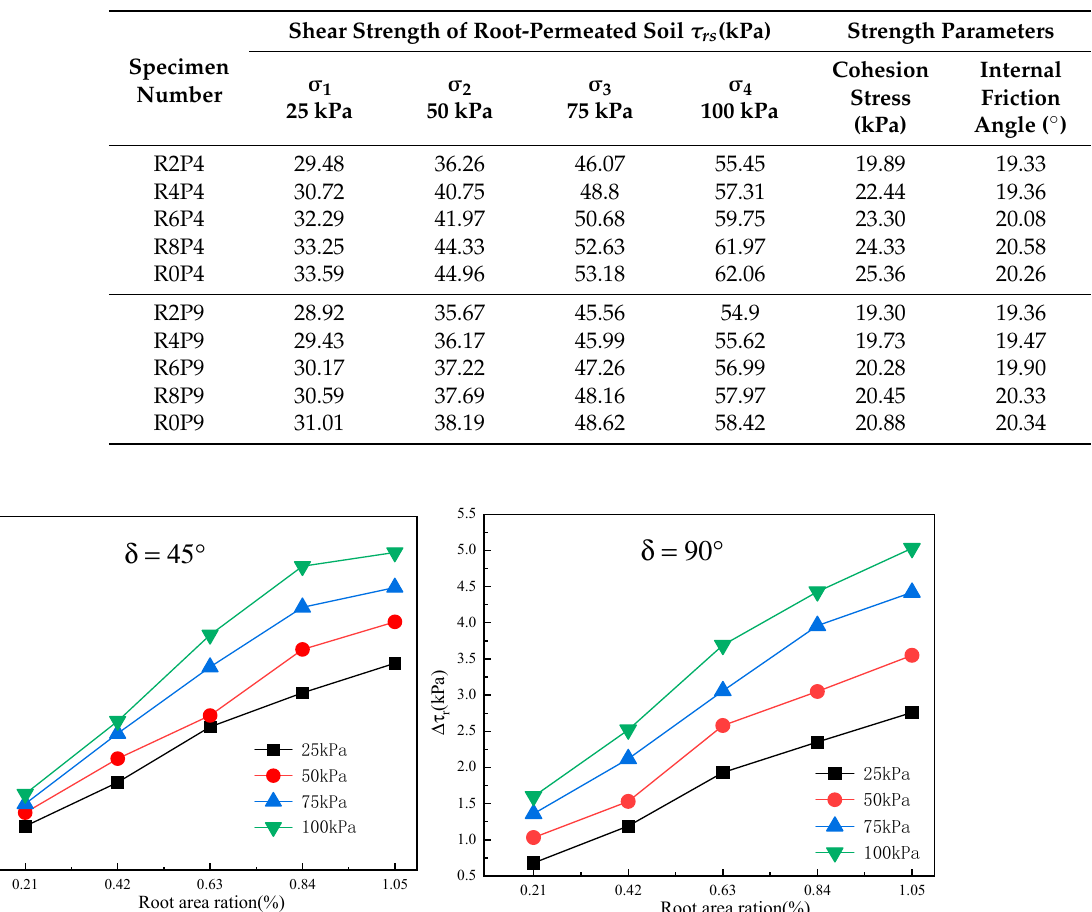
Figure 15. Roots reinforcement r